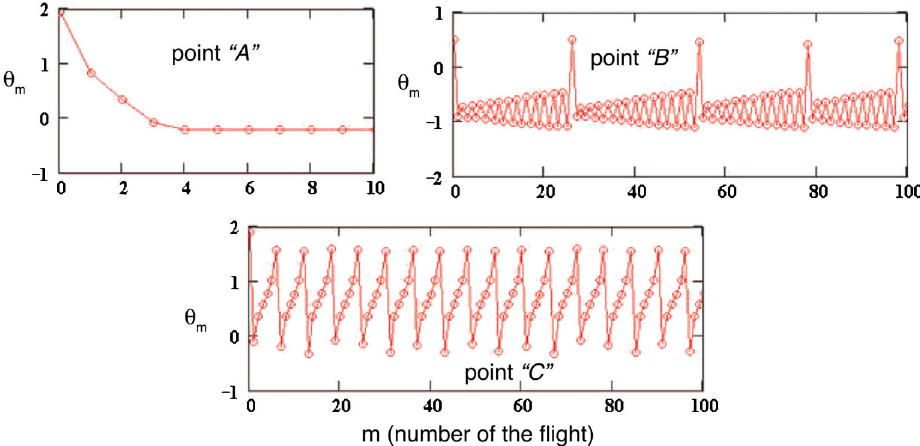
FIG. 7. Dependence of the starting phase on the number of the flight.